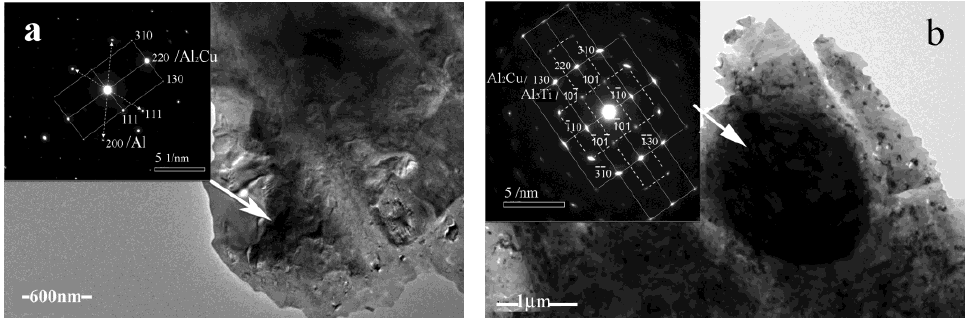
Figure 13. TEM photographs of typical Al 2 Cu particles in ADC12 alloys observed by a Tecnai G2 20ST TEM system: ( a ) a Al 2 Cu particle that did not contain Al 3 Ti particles for a B free alloy, and ( b ) a Al 2 Cu particle containing Al 3 Ti particles for an alloy containing B.